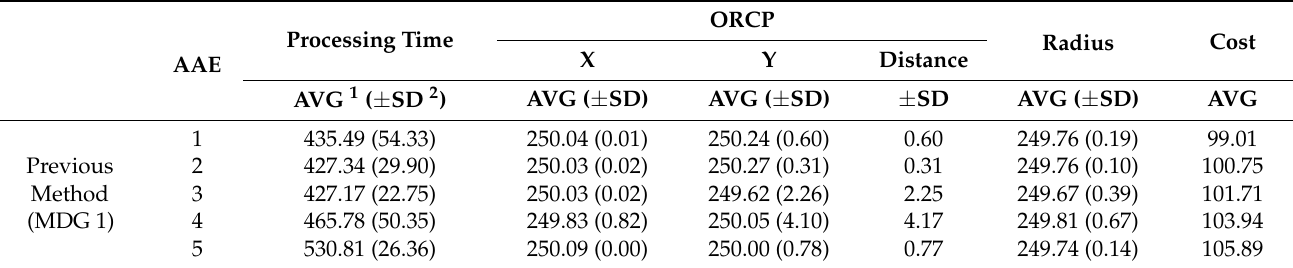
Table 2. Performance of HPOM estimation according to